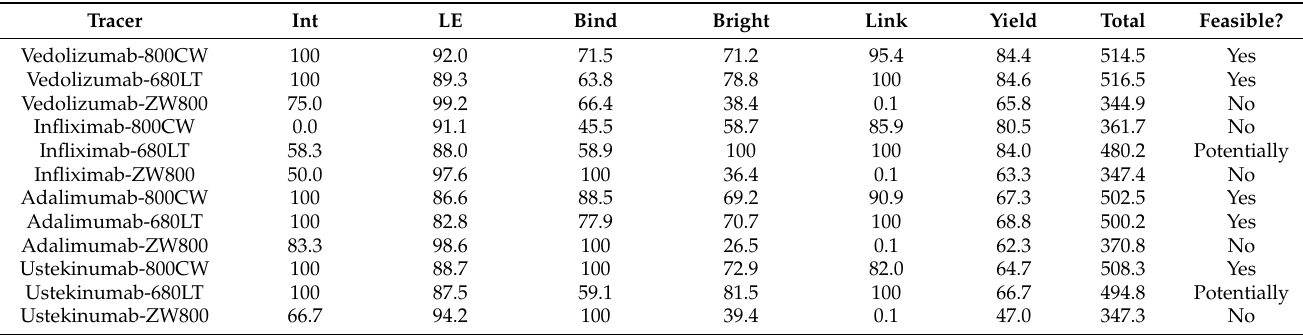
Table 1. Translational feasibility